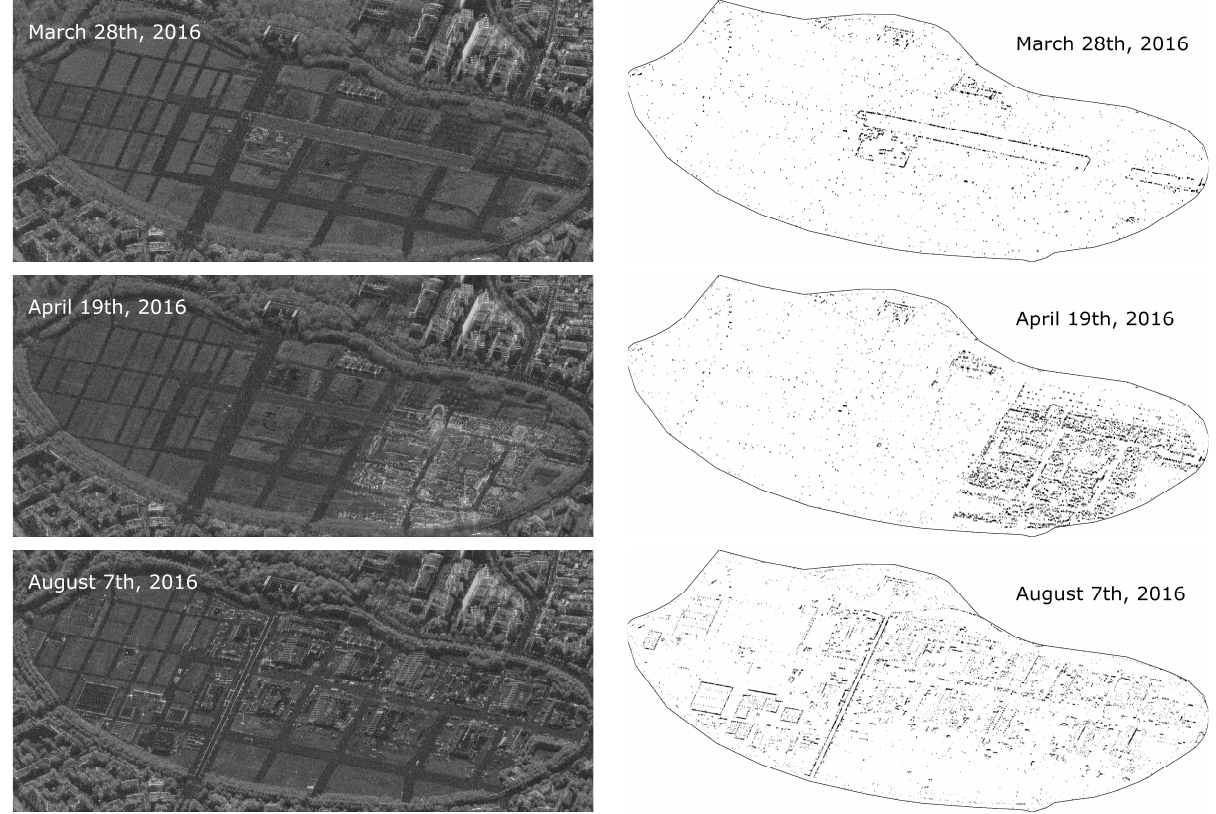
Figure 2. SAR images (left) and coherent scatterers (right) showing the Theresienwiese Park and its state at three different dates: March 28 th , with no event (top), April 19 th , during Spring Festival (centre), and August 7 th , during Oktoberfest preparations (bottom).